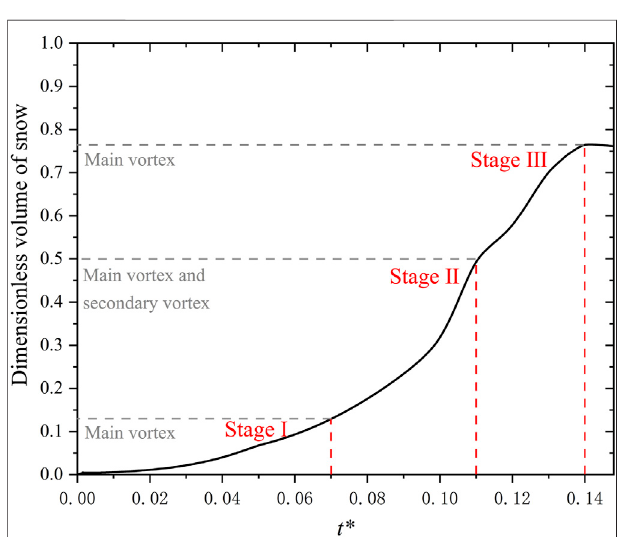
FIGURE 13 | Snow volume on the road at the different stages. To quantify the concerned road snow cover rate and amount, the changes of snow volume at the different stages are shown in Figure 12 . Before the cornice advanced toward the center of the leeward-side slope, this period of the main vortex acting alone constituted the drifting snow safety period ofthe cutting. Theperiod from theappearance ofthesecondaryvortex to the disappearance of the secondary vortex represented the period with a rapid increase in the snow cover. After the secondary vortex disappeared, the snow deposition rate slowed